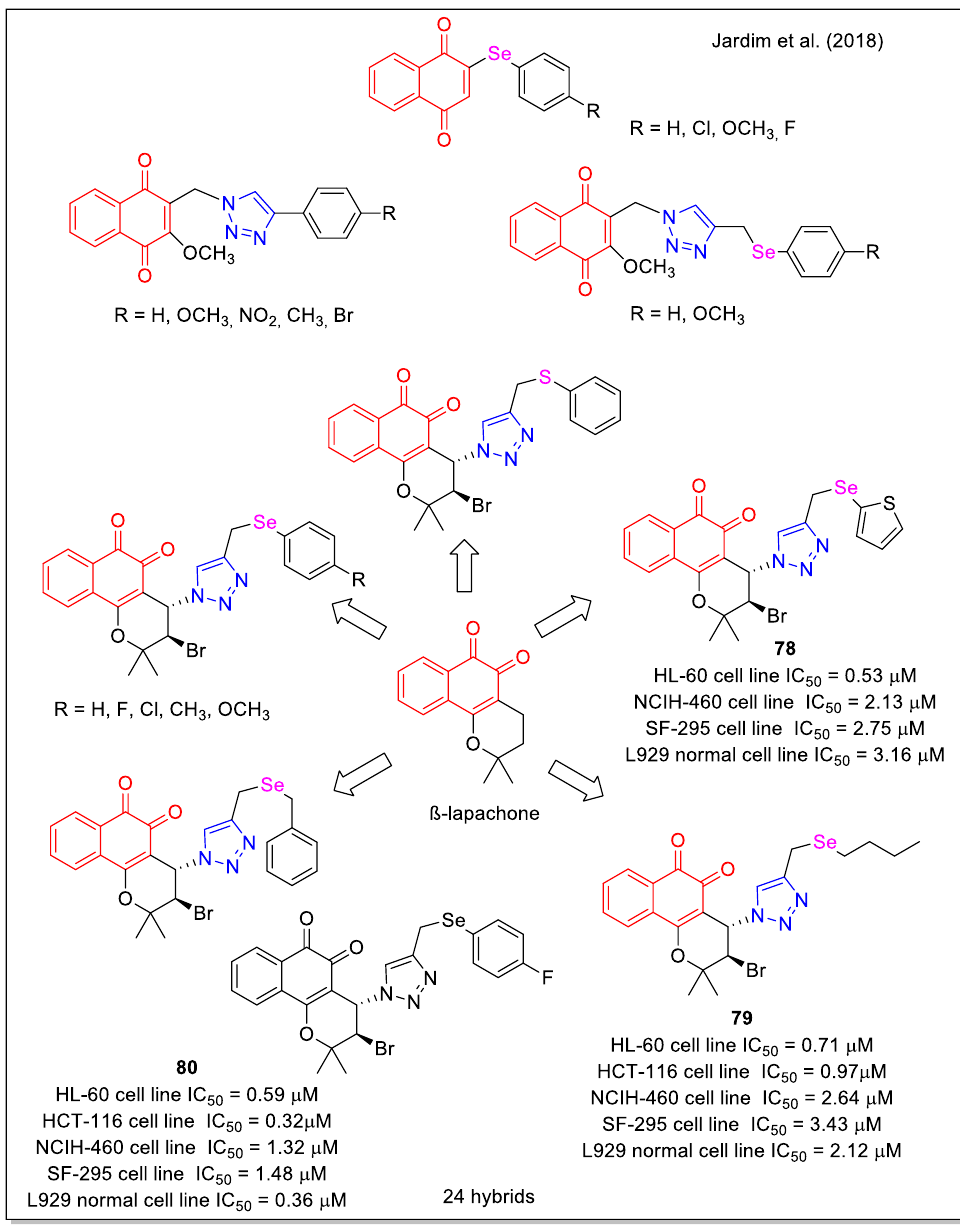
Figure 28. 1,4- and 1,2-Naphthoquinone – organoselenium hybrids as reported by Jardim et al. [69]. A further contribution to the structural diversity of NQ hybrids was given by the work performed by Gontijo et al. [70]. They obtained novel compounds by coupling the NQ units of α - and β -lapachone to the fluorescent BODIPY (=boron-dipyrromethene) core [70]. The synthetic strategy involved the use of the click chemistry of BODIPY-alkyne with the suitable azide on the NQ units. By evaluation on cancer and normal cell lines, com- pound 81 was identified as the most interesting (Figure 29). Studies on mechanisms in- volving lipid peroxidation and determination of reduced and oxidized glutathione were performed, indicating that the activity of 81 may be related to ROS production. Addition- ally, analysis by fluorescence confocal microscopy indicated that the cytotoxic compound 82 was preferentially localized in the lysosomes of cancer cells.